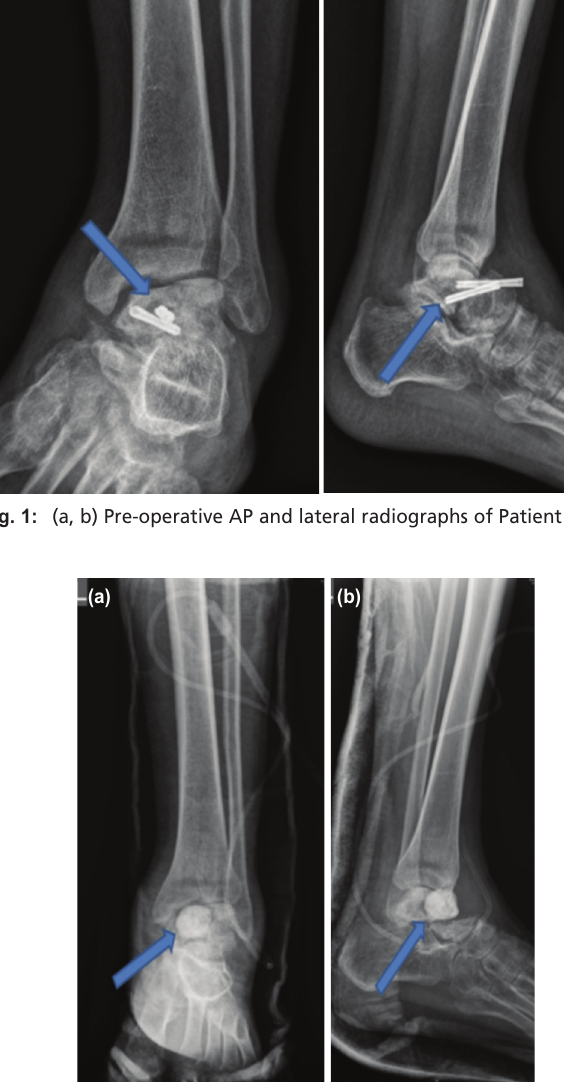
(a, b) 1st stage debridement and ALBC application with partial loss of talus in patient. Fig. 2: